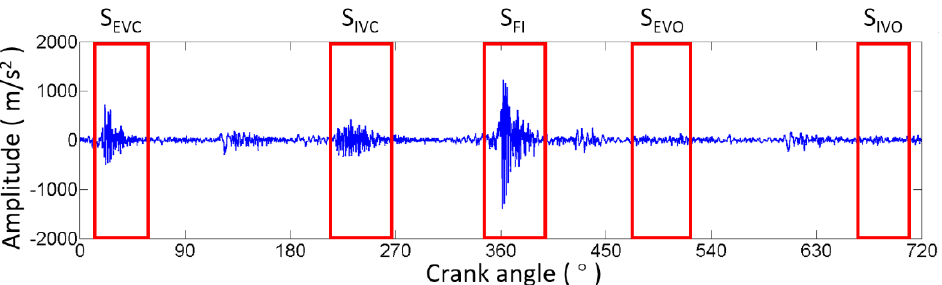
Figure 9. Raw vibration signal collected on the B1-cylinder head during one combustion cycle.